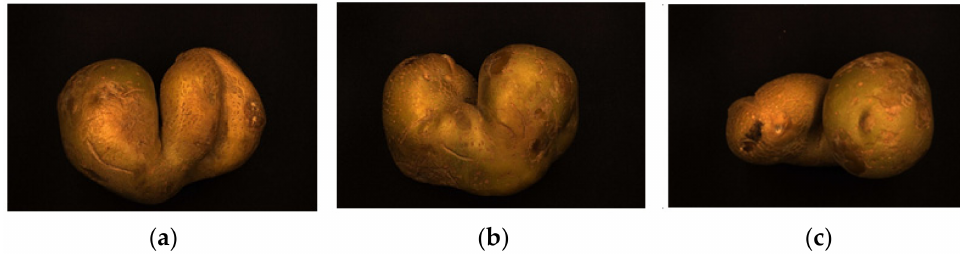
Figure 14. Images of an irregular potato from different shooting perspectives: ( a ) front shot, ( b ) back shot, and ( c ) side shot.